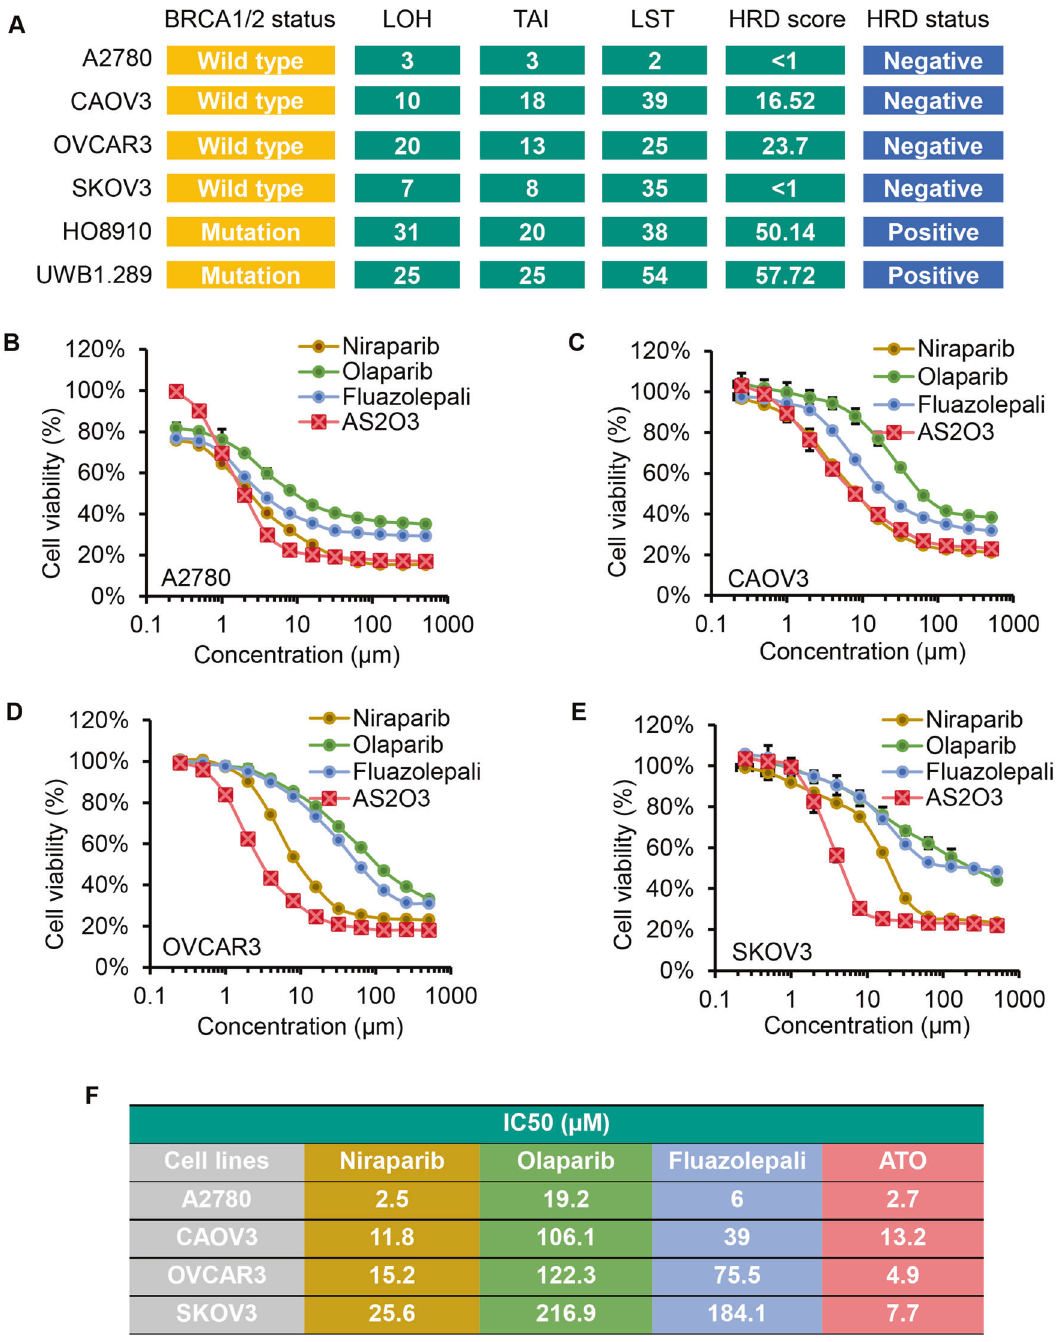
Fig. 1 The sensitivity of HR-pro fi cient ovarian cancer cell lines to PARP inhibitors and ATO. A BRCA1/2 and HRD status of selected ovarian cancer cell lines. B – F Drug-response curves of cell viability after PARP inhibitors (niraparib, olaparib, and fl uazolepali) and ATO treatment, respectively, in HR-pro fi cient ovarian cancer cells (A2780 ( B ), CAOV3 ( C ), OVCAR3 ( D ), and SKOV3 ( E )) measured by CCK8 assay at 72 h. Mean ± SD shown ( n = 3 biologically independent replicates per treatment and experiment repeated thrice). IC 50 was calculated by GraphPad Prism 9.0 ( F